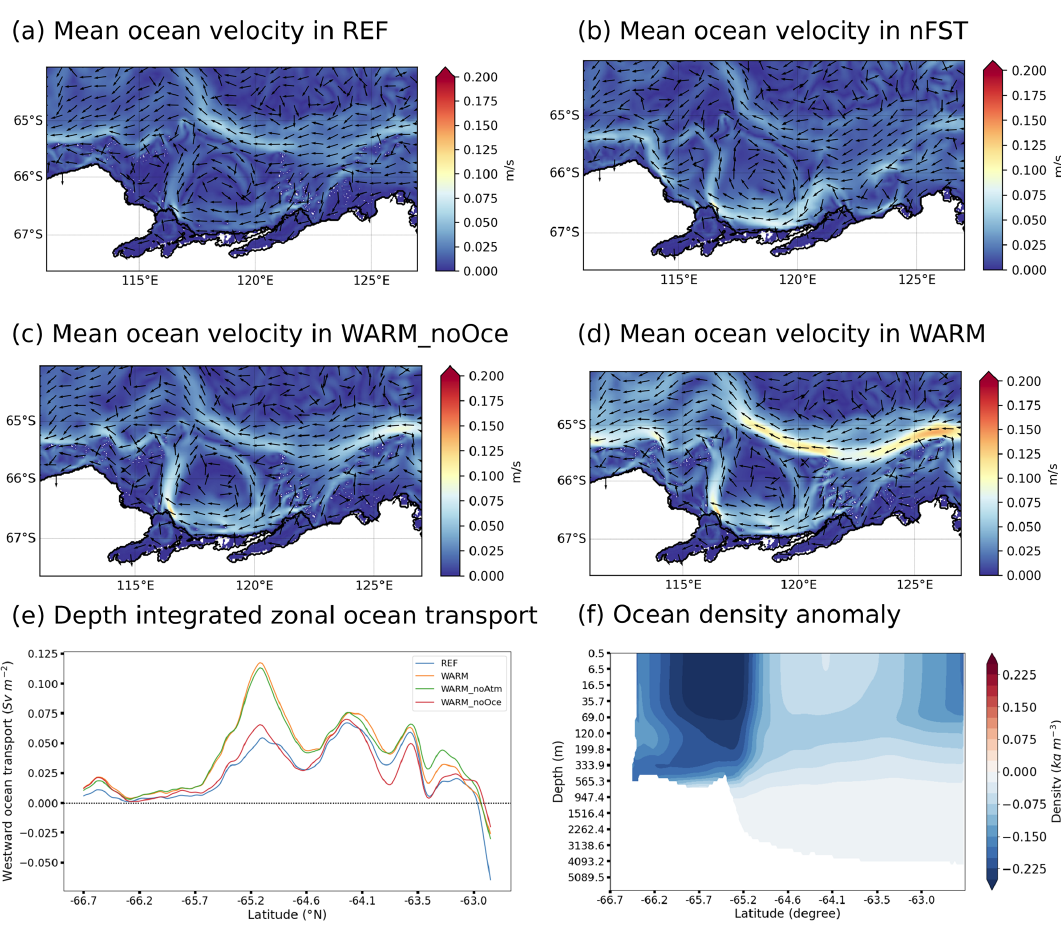
Figure 7. Annual mean, depth-averaged ocean velocity for the REF (a) , nFST (b) , WARM_noOce (c) and WARM (d) simulations, all aver- aged over the 20 years of simulation. (e) Annual mean, depth-integrated zonal ocean volume transport for the REF, WARM, WARM_noAtm and WARM_noOce simulations. (f) Meridional section of the ocean density change between WARM and REF. Table 2. Mean ice shelf basal melt rates for both the recent past and the end of the 21st century and for all simulations. Ice